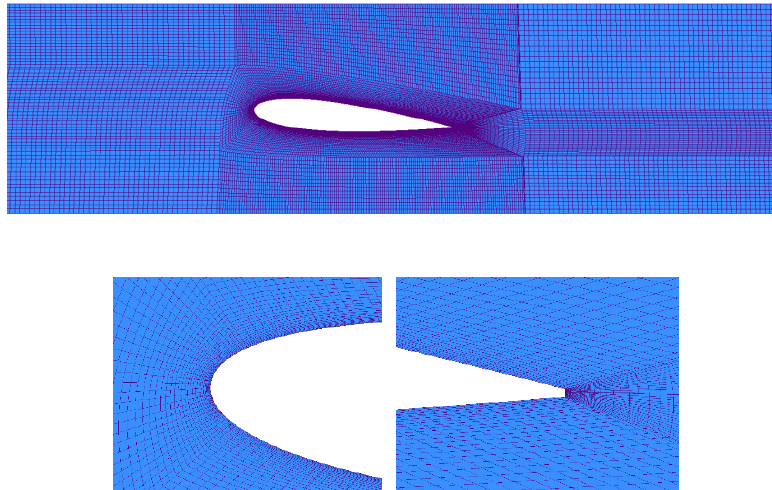
Processes 2020 , 8 , 278